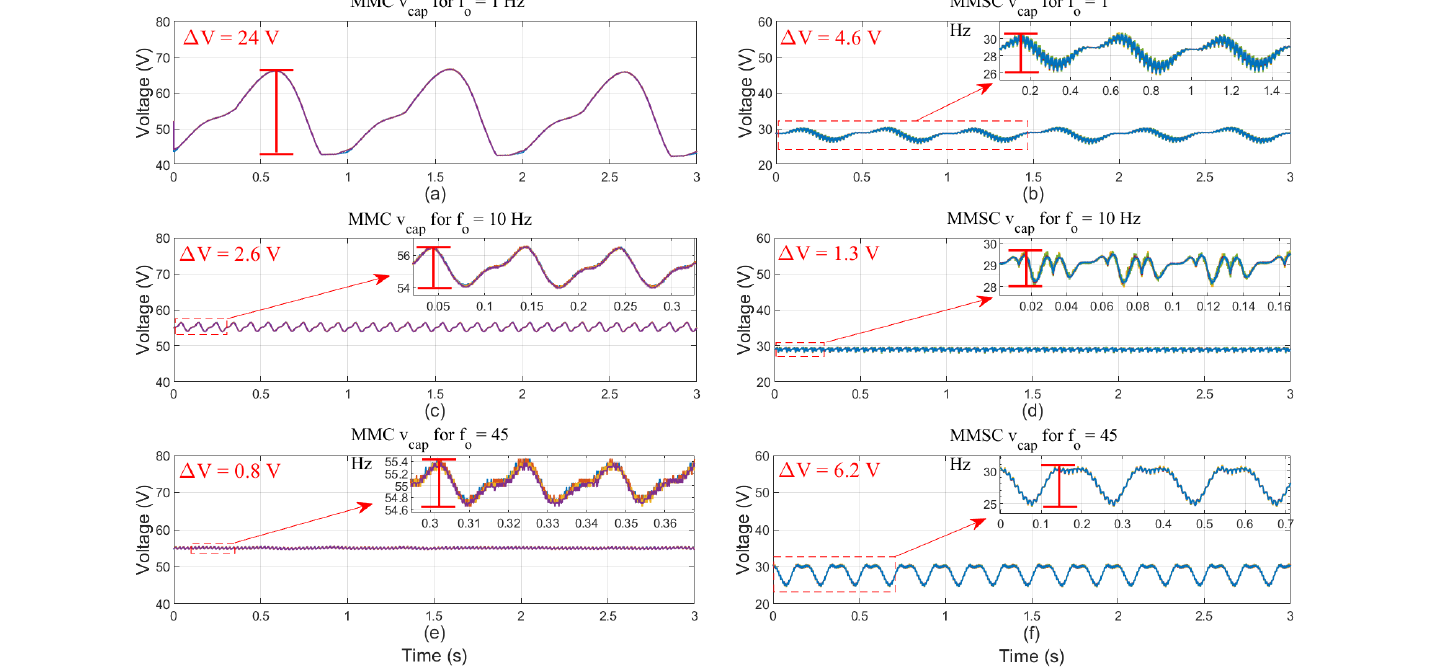
Figure 9. Experimental results. ( a , c , e ) MMC submodule-capacitor voltages for the cases in which f o = 1,10 and 45 Hz, respectively. ( b , d , f ) MMSC submodule-capacitor voltages for the cases in which f o = 1,10 and 45 Hz,